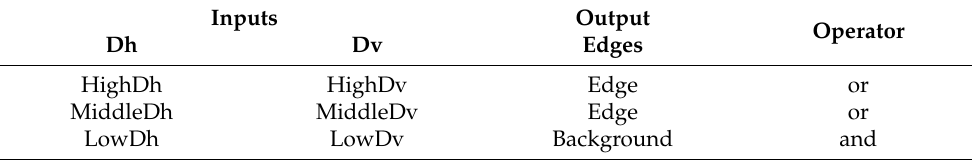
Table 3. Knowledge base with three fuzzy rules for Sobel/Prewitt fuzzy edge-detector. Inputs Output Operator Dh Dv Edges HighDh HighDv Edge or MiddleDh MiddleDv Edge or LowDh LowDv Background